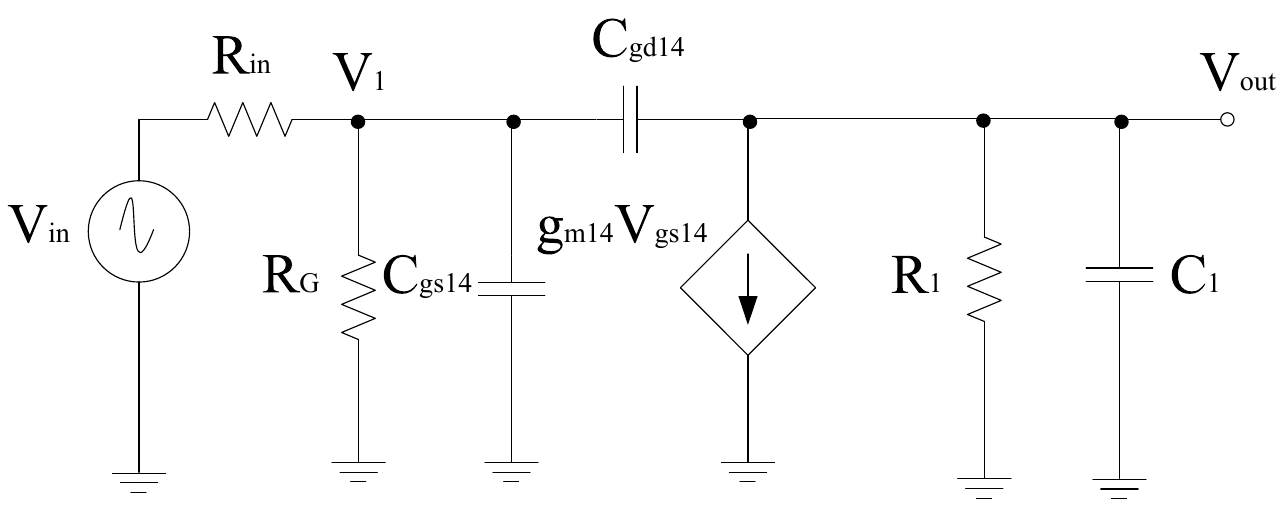
Figure 5. Equivalent small signal model for the RF+